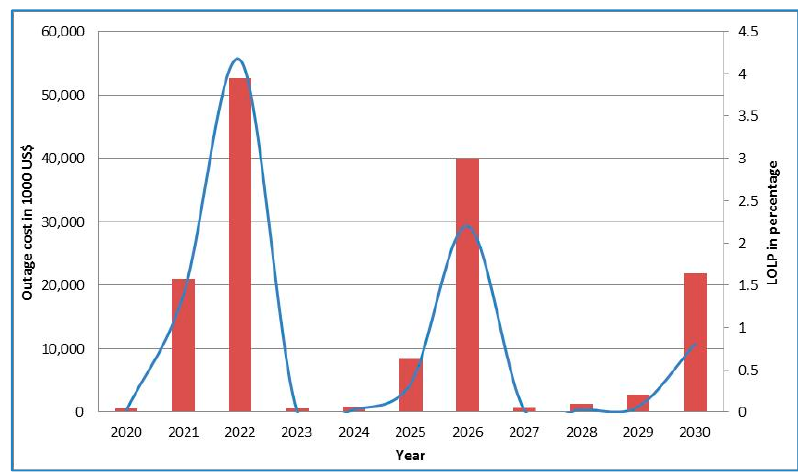
= 0.01% and VOLL $2 USD / kWh.